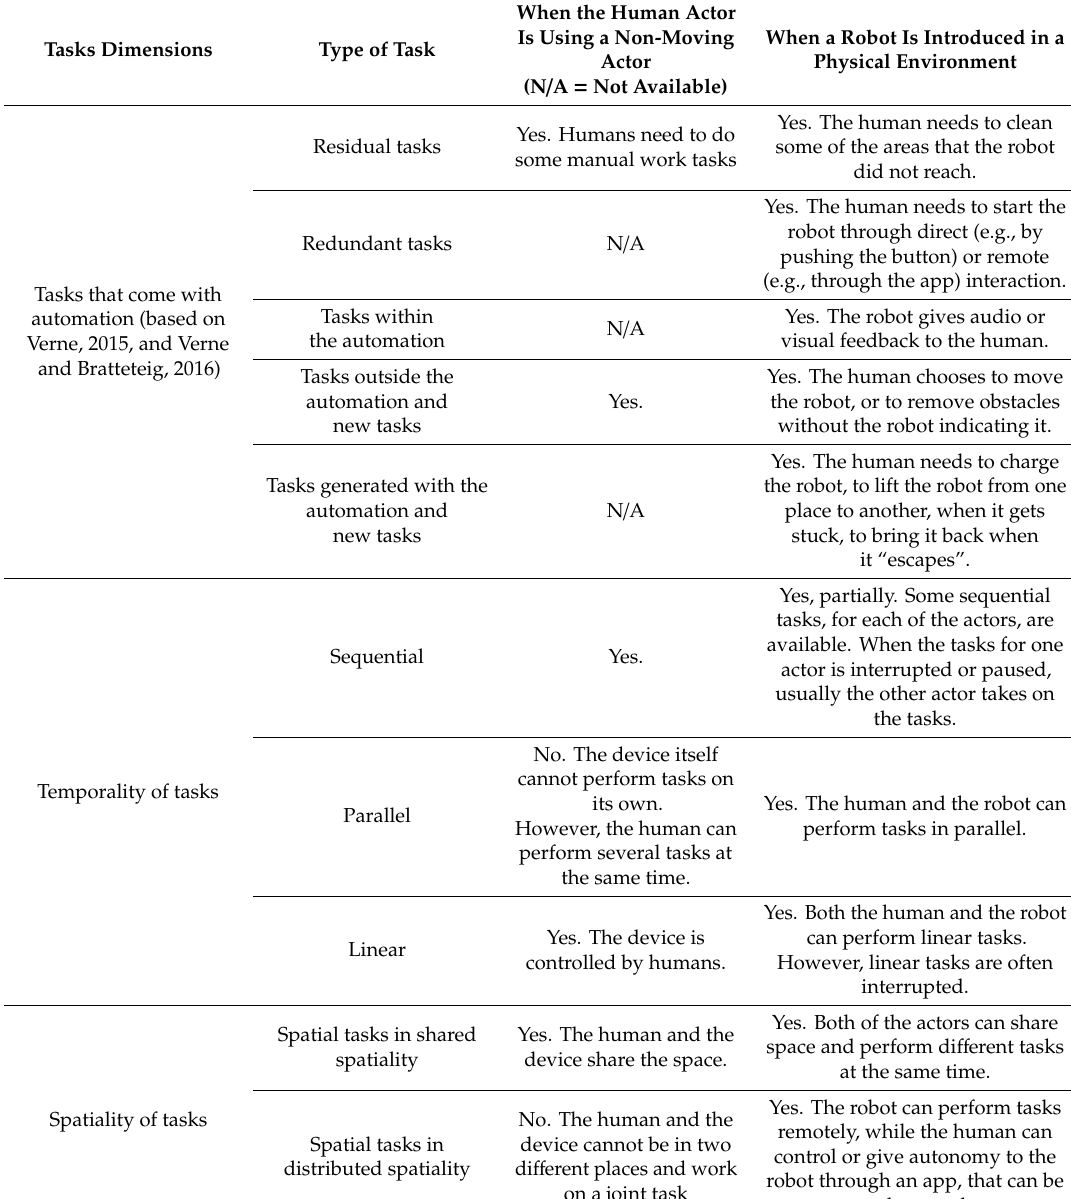
Table 4. Exemplified framework on the division of work tasks between humans and robots: including the spatial and temporal